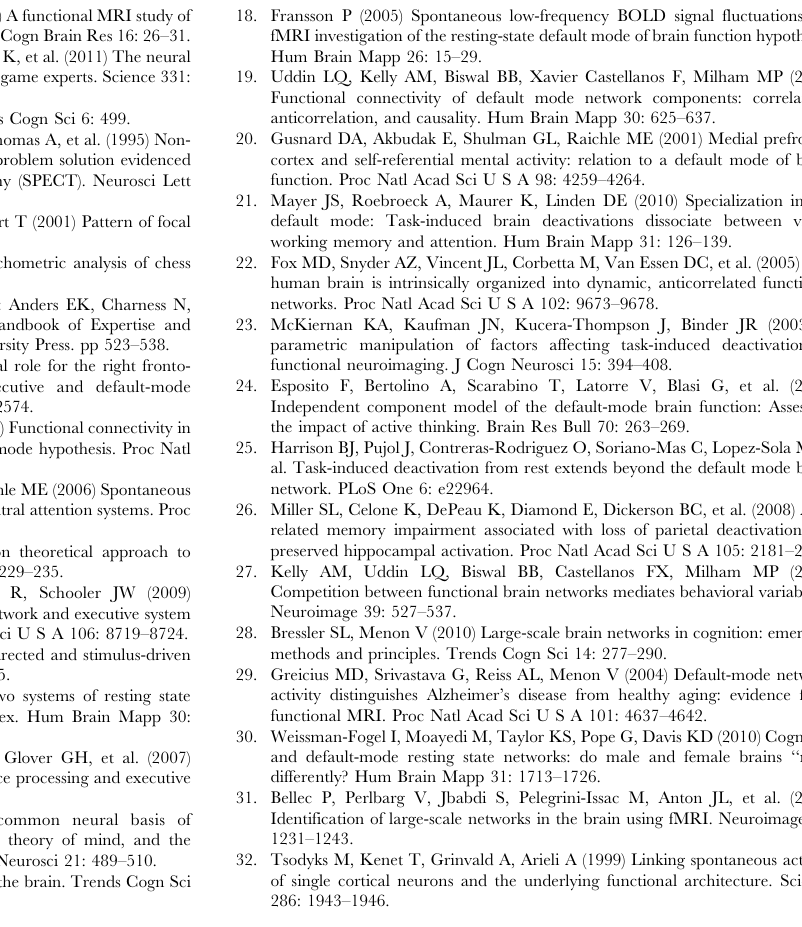
Figure S1 Activation in the cognitive networks and deactivation in the DMN during Chinese chess problem-solving task (Game condition vs. Random condition) in GM/Ms (A) and novices (B) (One-sample t test, p , 0.05, corrected for multiple comparison). C. Between-group comparison revealed deactivation differences in